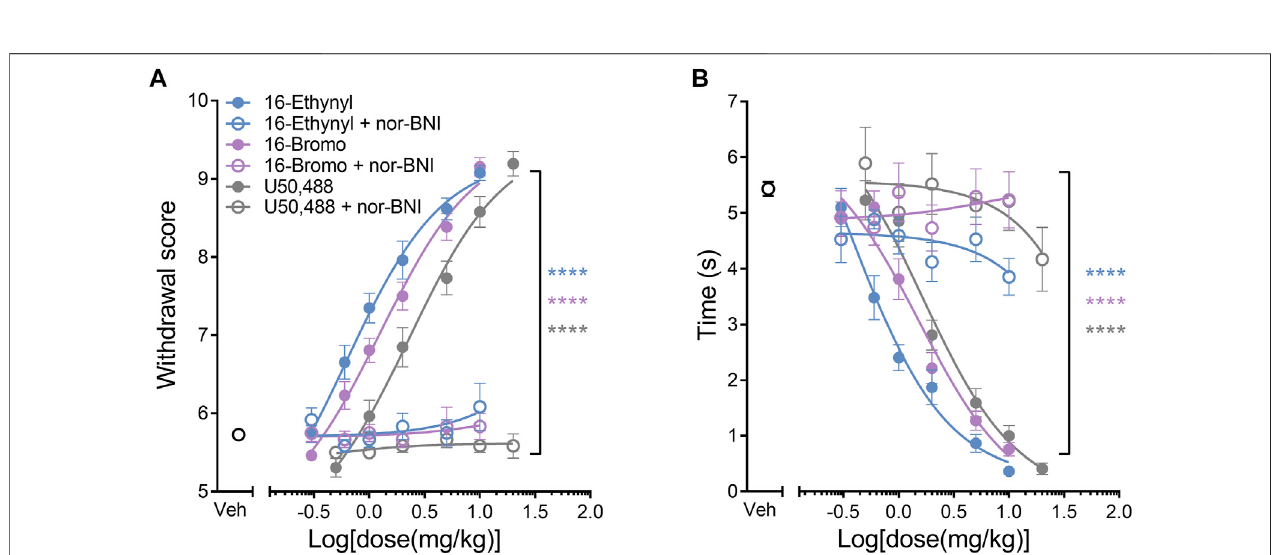
FIGURE 3 | KOR antagonism reduces the antinociceptive effect of the KOR agonists. The selective KOR antagonist nor- binaltorphimine ( nor- BNI, 10 mg/kg) was administered prior to the dose-response procedure. (A) Antinociceptive dose-response effects against mechanical allodynia. Nor- BNI reduced the antinociceptive effectsoftheKORagonistsatthehighestdosefor16-EthynylSalA,16-BromoSalA(10 mg/kg)andU50,488(20 mg/kg)tothemechanicalstimulus. (B) Antinociceptive dose-response effects against cold allodynia. Nor- BNI reduced the antinociceptive effects of the KOR agonists to the cold stimulus. One-way ANOVA with Bonferroni post-tests. Values presented as mean ± SEM. n = 13 for KOR agonist treatment, n = 6 for groups with nor- BNI pre-treatment. **** p < 0.0001 indicates comparison between treatment with and without pre-treatment of nor- BNI.